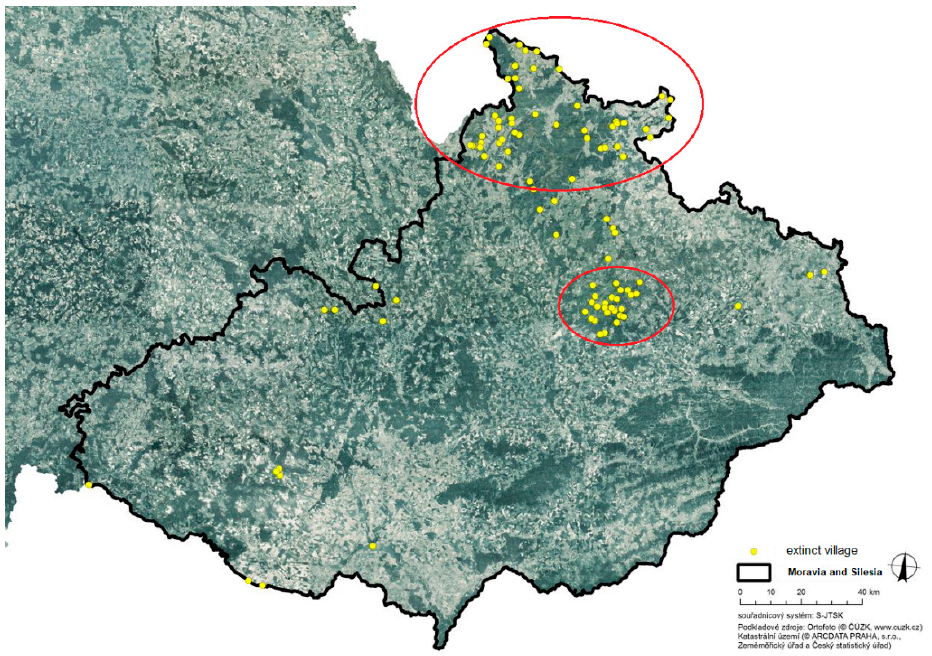
Figure 2. The location of extinct settlements within the territory of Moravia and Silesia. Source: Orthophoto © Č ÚZK, © ARCDATA PRAHA; editing by Pe ř inková, V., Maší č ek, T.